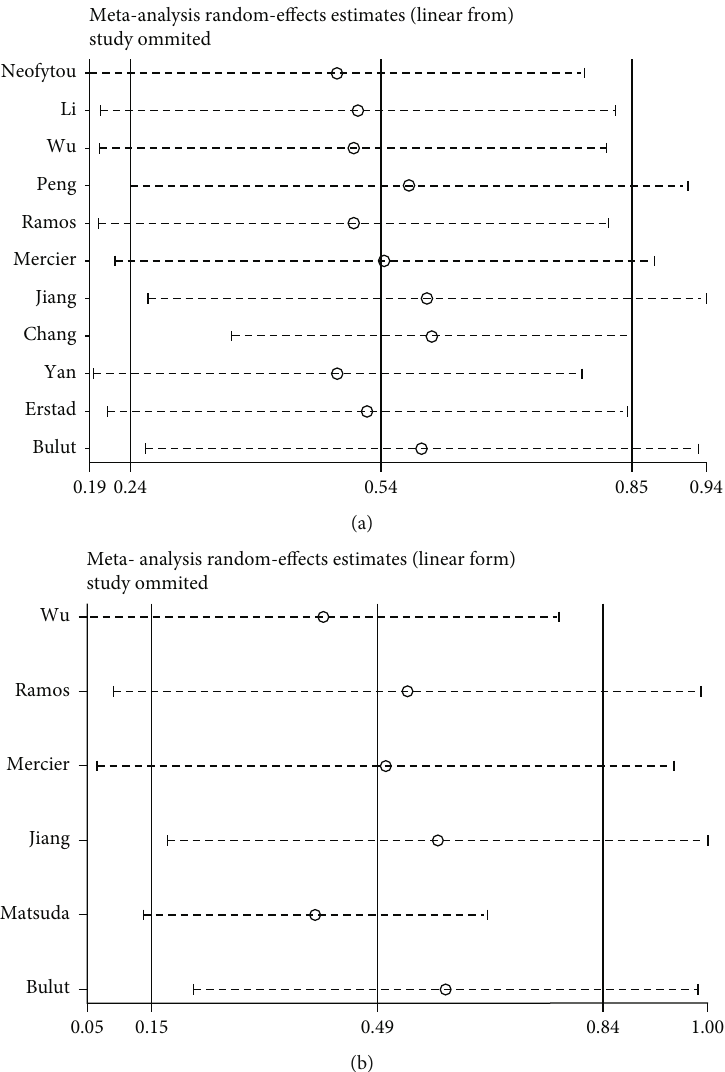
Figure 5: (a) Sensitivity analysis for the association between PLR and OS. (b) Sensitivity analysis for the association between PLR and